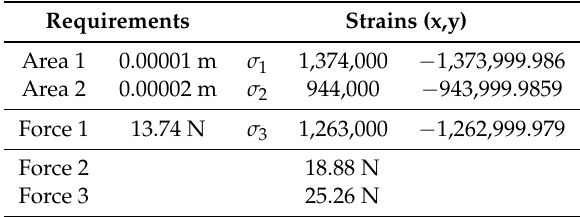
Table 7. Variables related to the experimental forces measured.